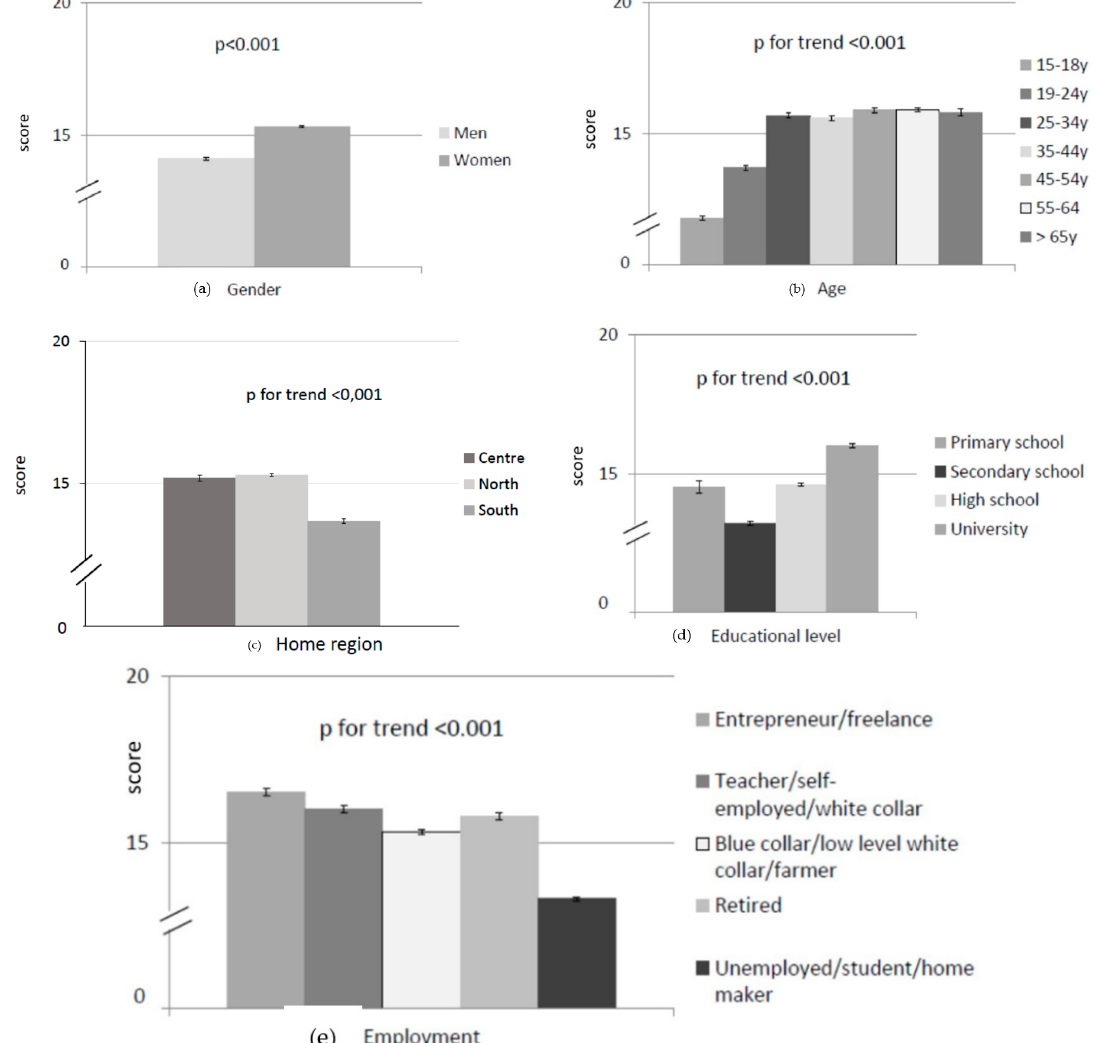
Figure 2. Behaviour about salt intake in relation to sociodemographic factors: ( a ) gender; ( b ) age; ( c ) home region; ( d ) educational level; and ( e ) employment. Results are expressed as mean ± standard error ( n = 11,618).